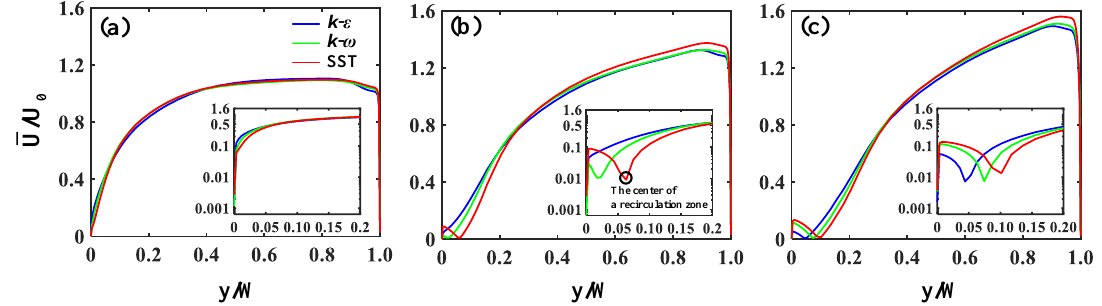
Figure 7. Distributions of depth-averaged mean velocity at the cross-section crossing the center of recirculation zones for ( a ) S136, ( b ) S157, and ( c ) S190. The insets plot the distributions with the logarithmic scale on y -axis.